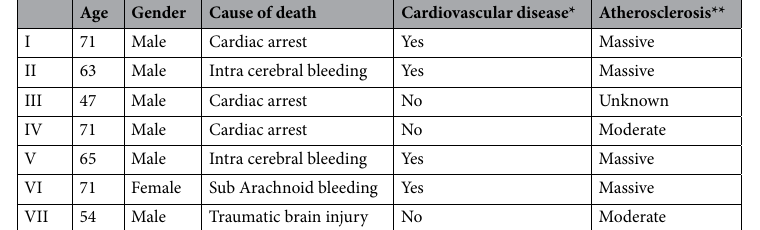
Table 2. Deceased kidney donor characteristics. *Cardiovascular disease defined as cerebrovascular event, myocardial infarction, vascular disease requiring invasive intervention; **as noted by the procurement team; Corresponding autoradiography and histology results are presented in Supplementary S2; no donors with diabetes